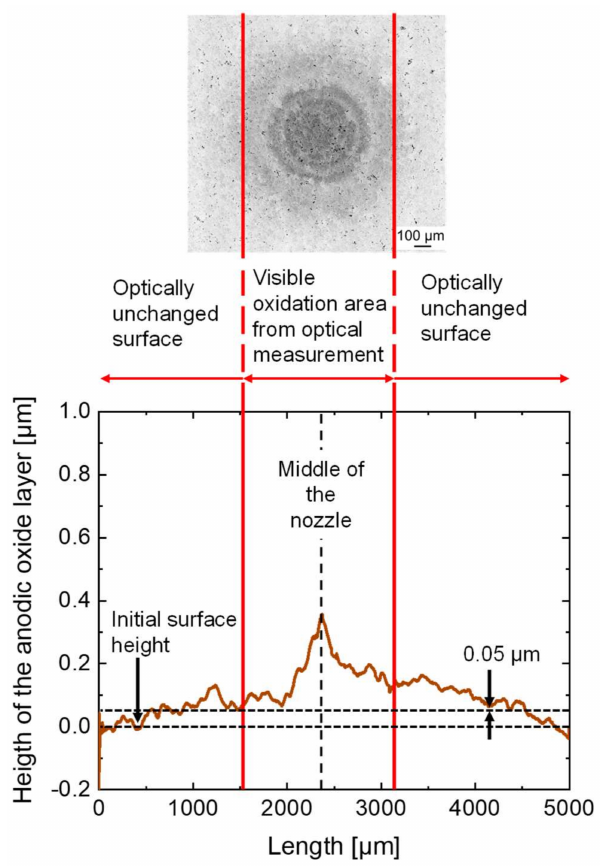
Figure 10. Result of the tactile measurement of the oxide area after the jet-based anodization— experiment no. 3.